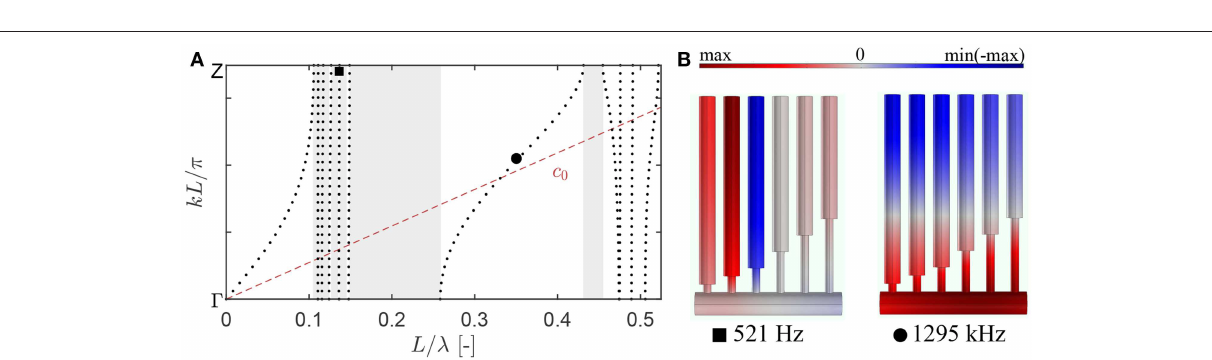
corresponding dispersion relation with the band gaps shaded in gray. The lowest pass band is strongly dispersive with the phase velocity ω/ k lower than c 0 (cf. the pass band c 0 for a sound wave in free air shown by the dashed red line), indicating the activation of slow sound conditions at these frequencies (Theocharis et